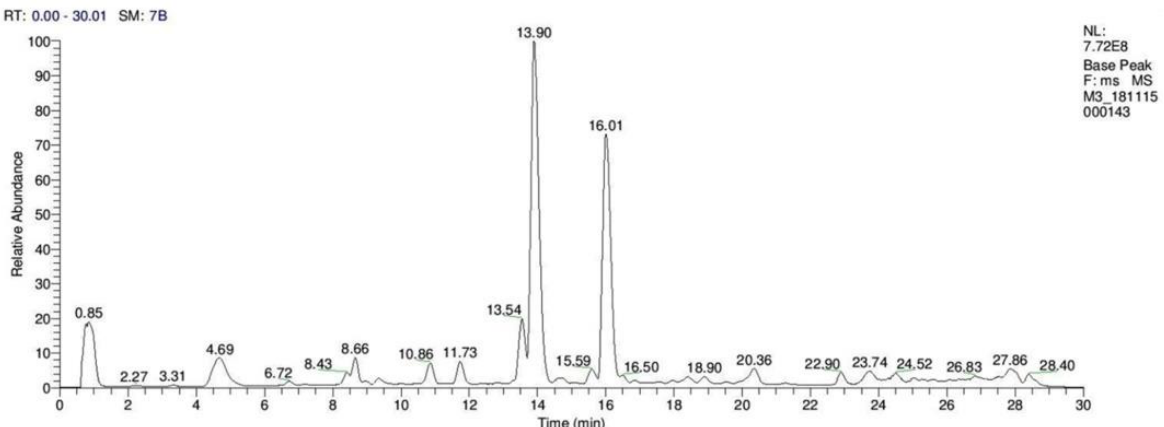
Figure 3. High resolution-liquid chromatography–mass spectrometry (HR-LC–MS) spectrum of S. repanda crude extract.